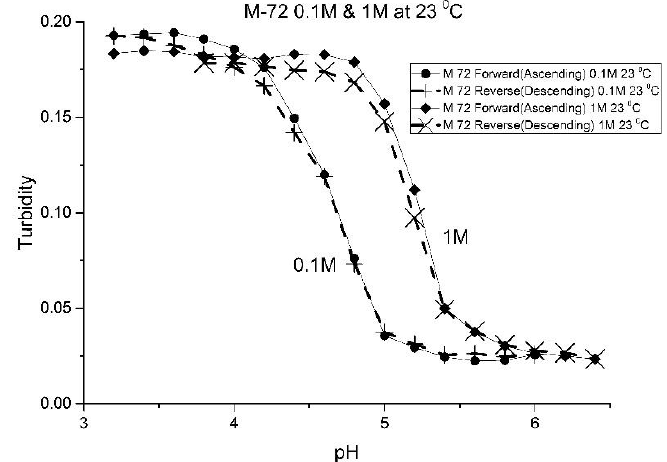
Figure 9. Ascending and descending pH profiles for polymer particles of M-72 at 0.1 M and 1M ionic strength and 23 °C. Solid line = ascending pH profile. Dashed line = descending pH profile.